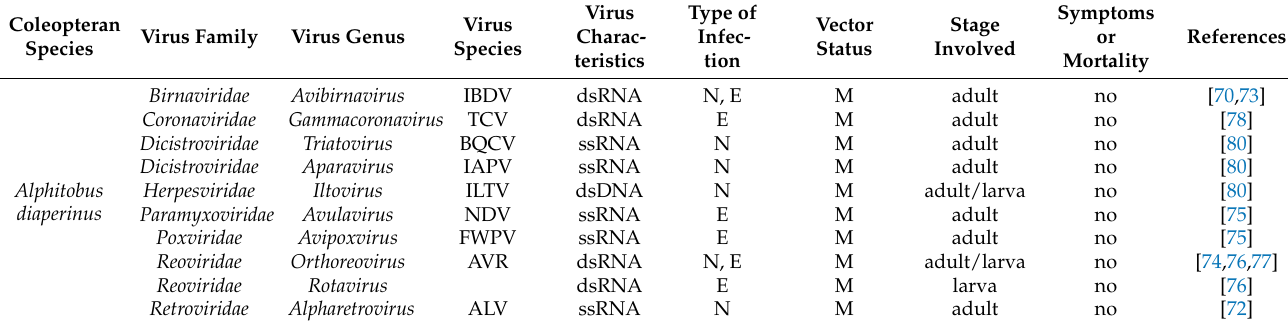
Table 2. Viruses detected in coleopteran edible